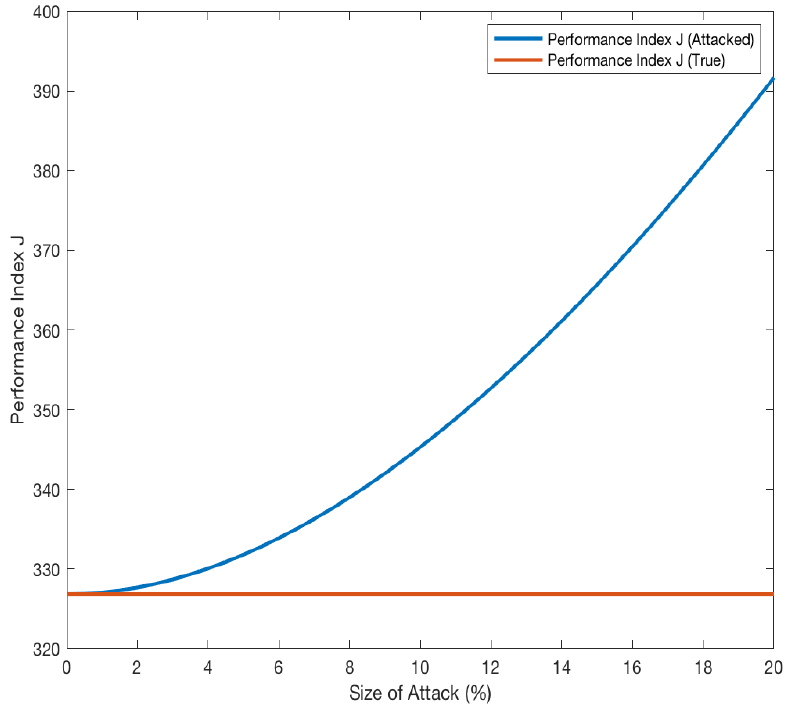
Figure 6. Performance Index (J) multiple lines case.